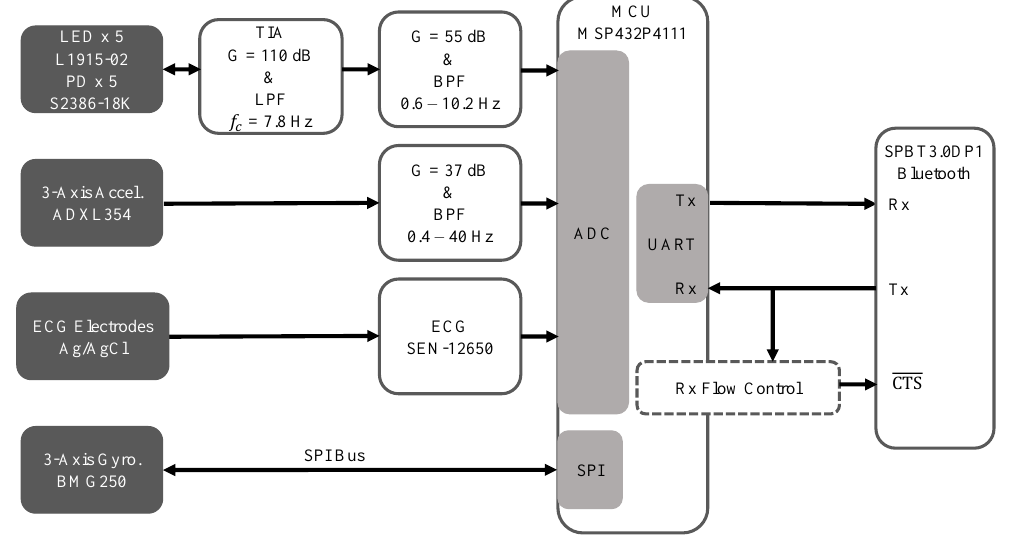
Figure 4. Hardware architecture for acquiring ECG, SCG, GCG, and